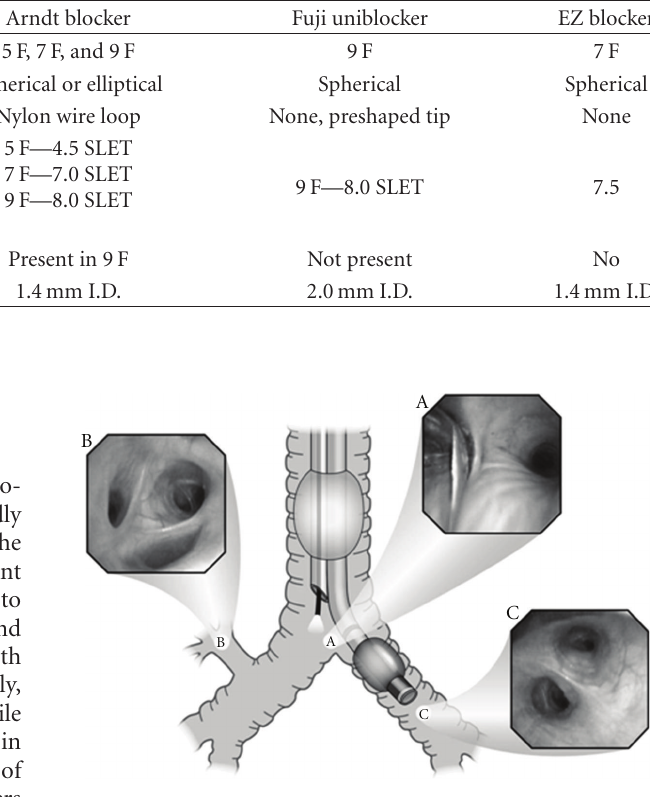
Figure 3: The proper position of a left-sided DLT when seen with a fiberoptic bronchoscope. (A) View of the tracheal carina, towards the left side the endobronchial lumen is visible, the left main bronchus with the outer surface of the endobronchial balloon is seen below tracheal carina. (B) View of the 3 orifices of the right upper lobe bronchus (apical, anterior, and posterior segments). (C) Clear view of the left upper and left lower